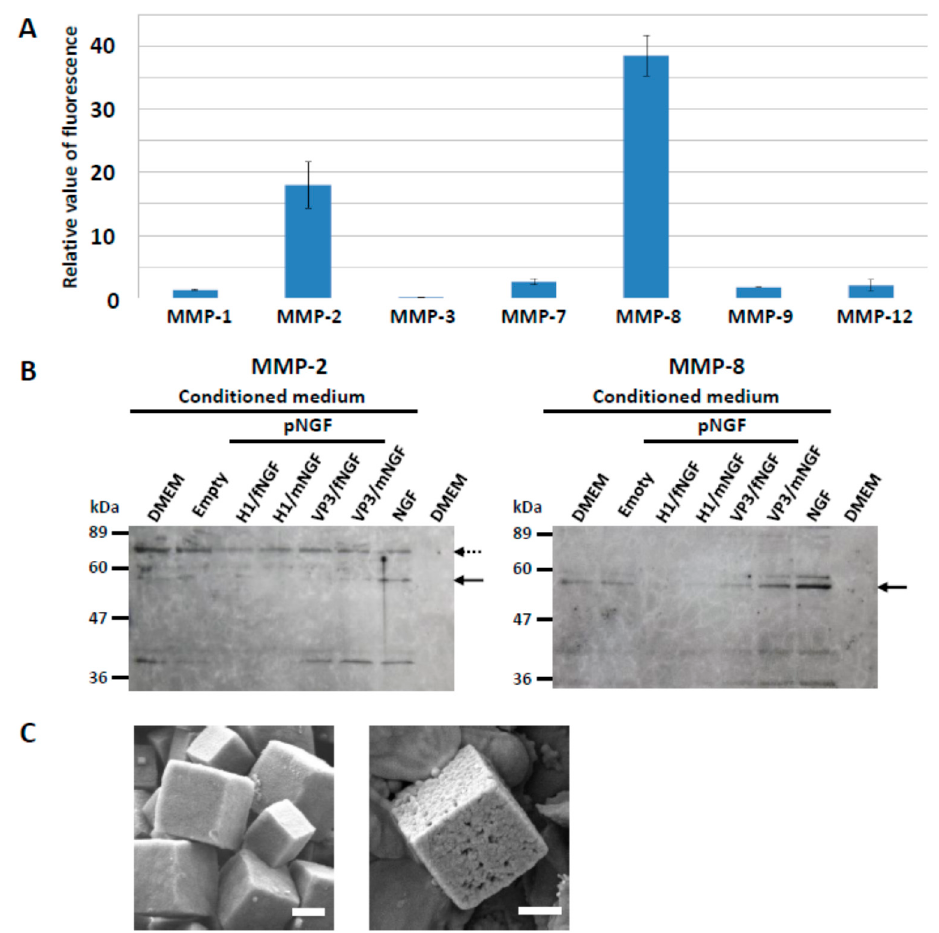
Figure 1. Release of cargo proteins by MMPs. ( A ) Analysis of proteins released from PODS. After H1-tagged pEGFP was incubated with MMP-1, -2, -3, -7, -8, -9, and -12 for 72 h at 35 °C, the fluorescence of EGFP released from nanoparticles was measured and shown as a relative value compared with a condition without each MMP. The relative fluorescence value was obtained by comparison with controls which were incubated without enzyme in Supplementary Table S1. ( B ) Secretion of MMPs from PC12 cells. Cells were incubated in serum free medium (DMEM) containing pNGF (NGF full-length (fNGF) and mature (mNGF) tagged with either H1 or VP3), empty PODS nanoparticles (Empty) and NGF-2.5S (NGF). Proteins secreted into the medium (conditioned medium) were subjected to SDS-PAGE and Western blot analysis by use of anti-MMP-2 (left) and anti-MMP-8 (right) antibody. The arrow and hatched arrow indicate the active form and pro-form, respectively. The larger protein fragment (seen above the band indicated by the arrow in the MMP-8 panel) is likely derived from a single nucleotide polymorphism of the MMP-8 gene [21]. Lower bands were also thought to be the degraded products of each MMP. ( C ) PODS nanoparticles were purified (left, control) and subsequently incubated with proteases at 37 °C (right) and imaged with scanning electron microscopy (SEM). Scale bars, 1 μ m.